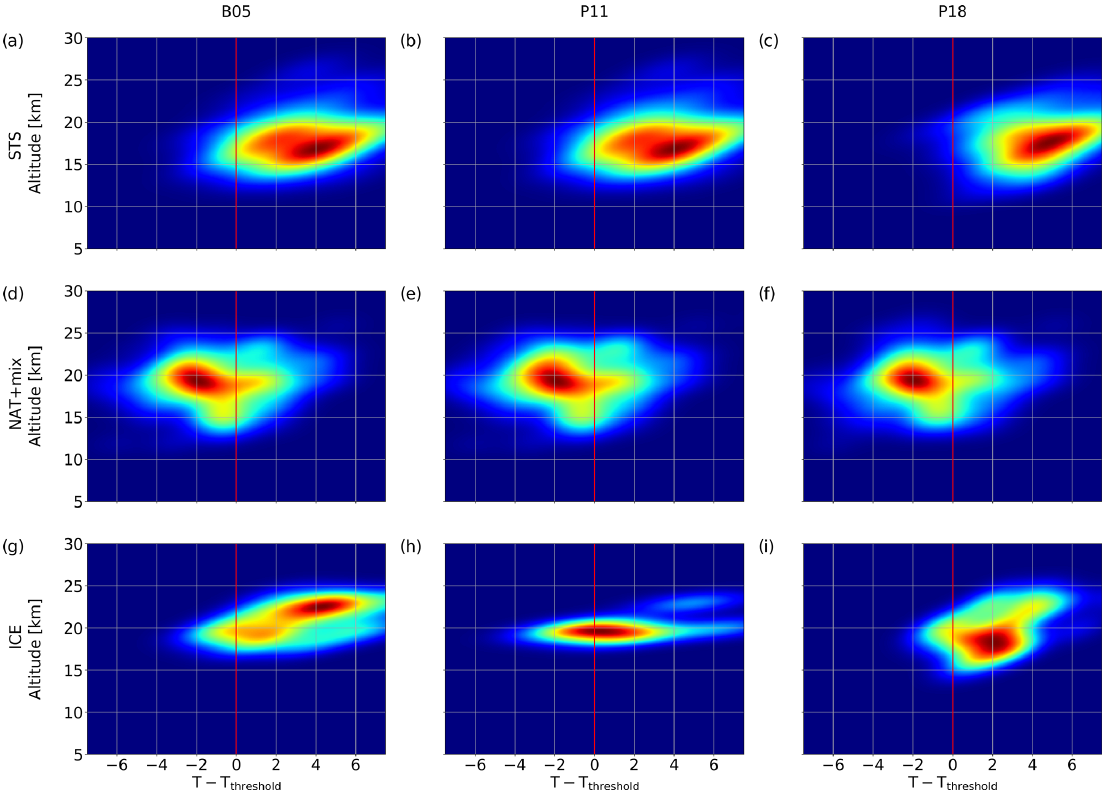
Figure 5. Distribution of PSC detection at DDU from 2007 to 2020 as a function of altitude and temperature relative to the relevant thresholds T STS , T NAT and T ICE . Lines correspond to STS (a–c) , NAT + mixtures (d–f) and ICE (g–i) . Columns correspond to the classification schemes B05 (a, d, g) , P11 (b, e, h) and P18 (c, f, i) .